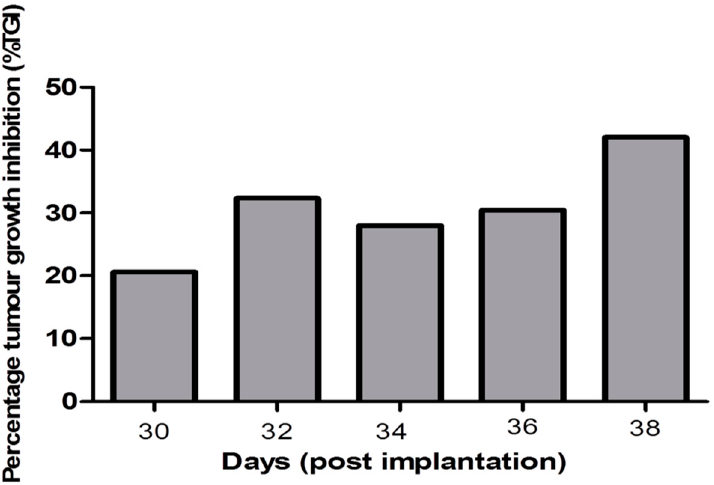
Figure 10. Percentage tumor growth inhibition (% TGI) in Group III (treated by NT 3–12 peptide- loaded NPs 10 mg kg − 1 ) relative to Group I (control group).